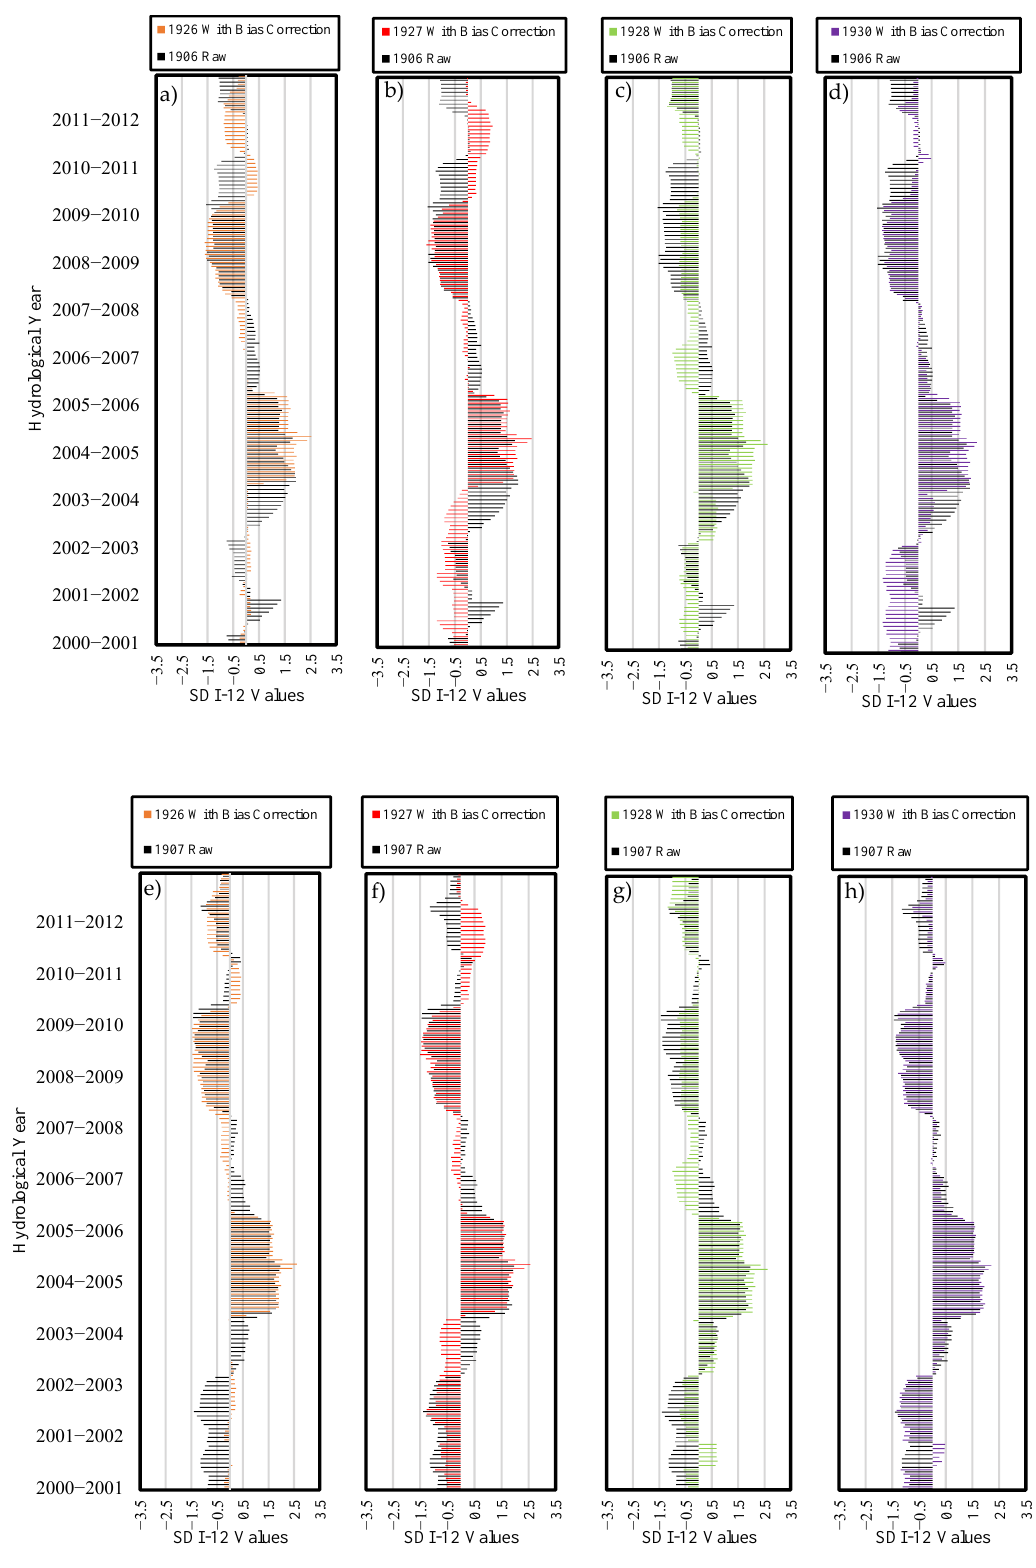
Figure 8. Obtained SDI-12 values for the transfer cases to the target SGSs. ( a ) 1926 and 1906, ( b ) 1927 and 1906, ( c ) 1928 and 1906, ( d ) 1930 and 1906, ( e ) 1926 and 1907, ( f ) 1927 and 1907, ( g ) 1928 and 1907, ( h ) 1930 and 1907